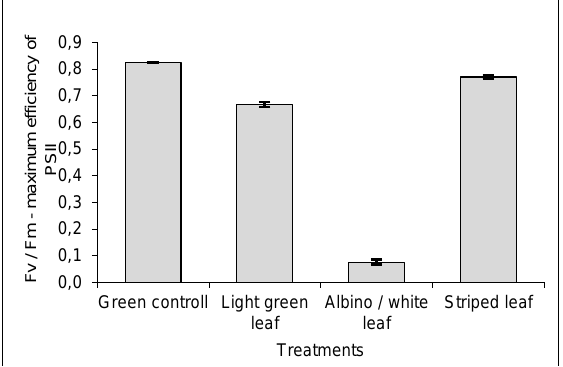
Figure 7. Photosynthetic activity (Fv/Fm ratio) of giant reed leaf variants It was significant differences (p<0.05) between types (Tukey